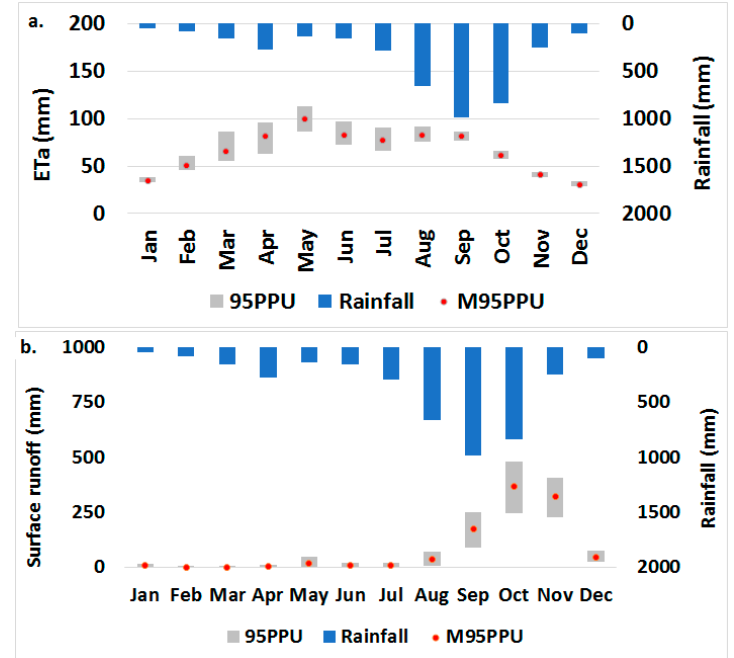
Figure 10. Average monthly ( a ) evapotranspiration and ( b ) surface runoff against rainfall. The gray bands show 95% prediction uncertainty (95PPU) and the red stars show the median of iteration (during 2006–2013).